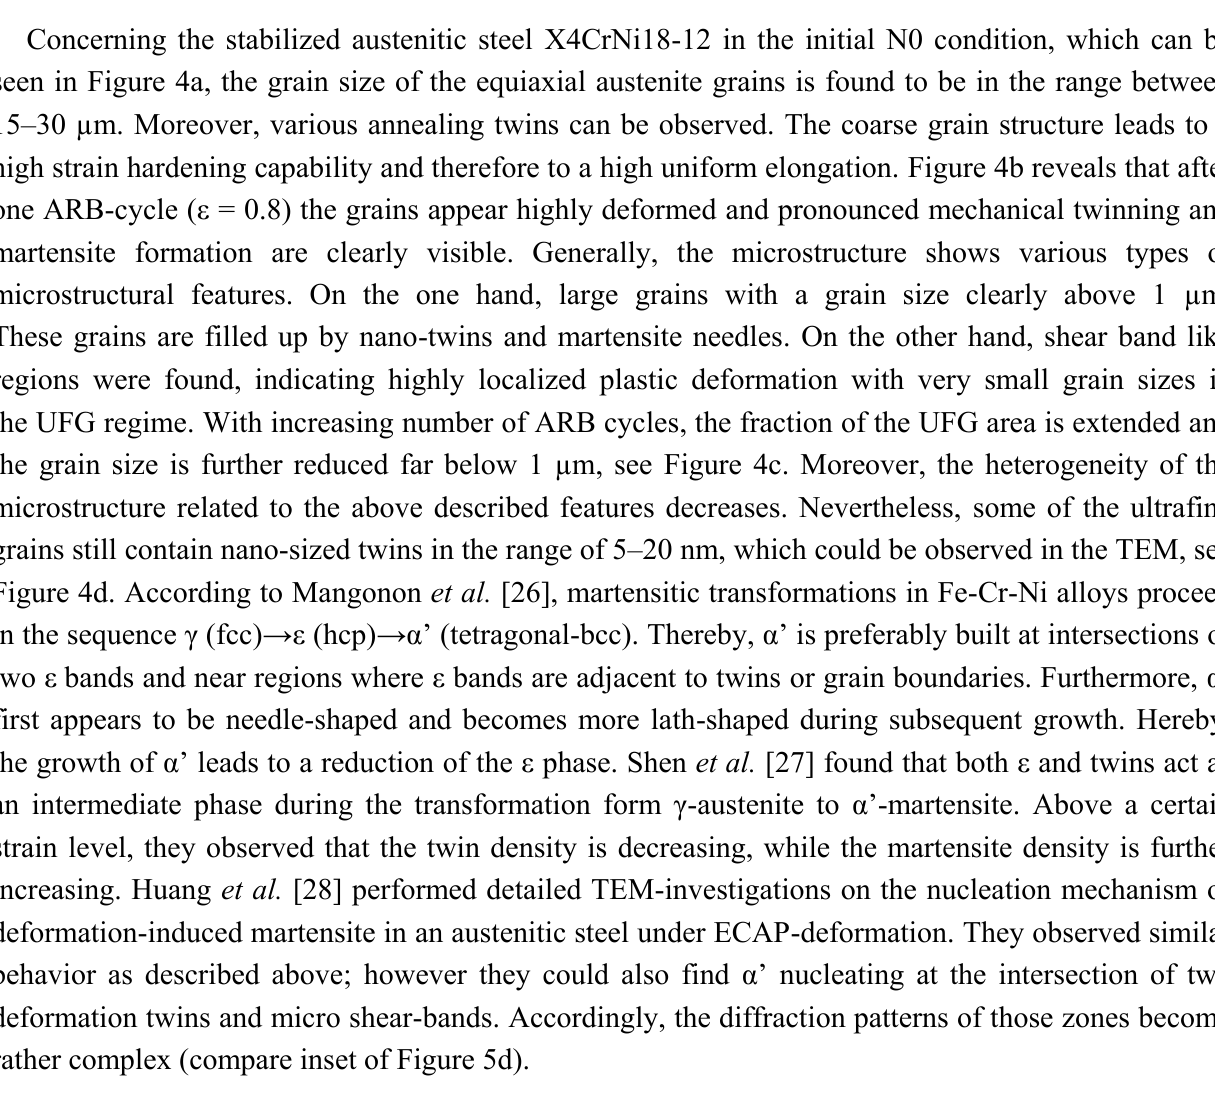
Figure 3. True maximum stress in MPa vs. strain rate for ( a ) X4CrNi18-12 and ( b ) X8CrMnNi19-6-3. The slope of the curves equals the strain rate sensitivity m N x